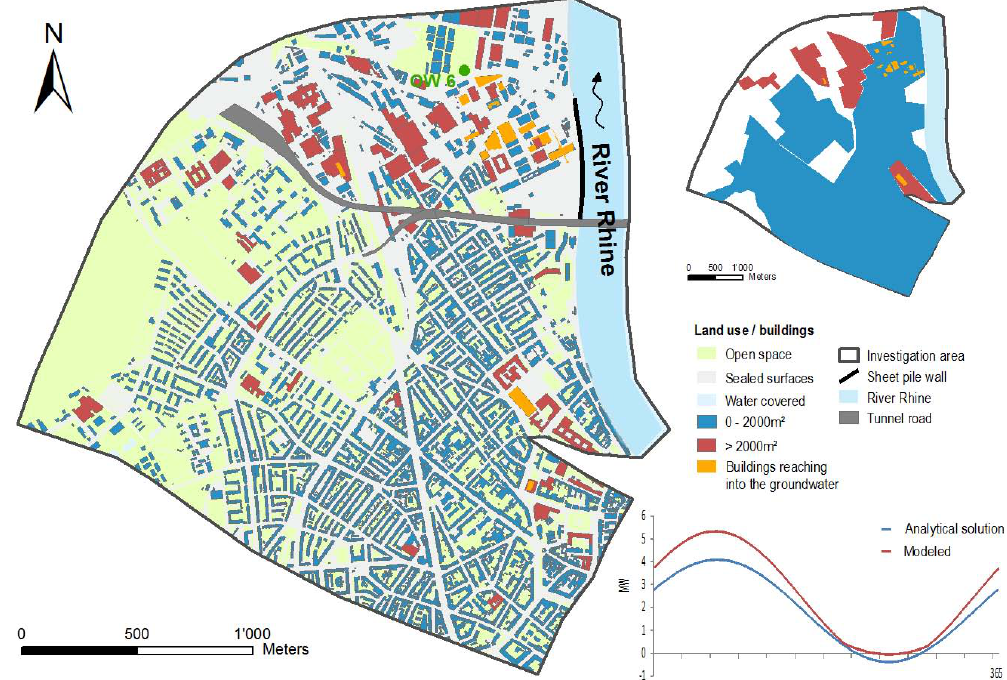
Fig. 2. Left panel: land use in the study area OW6: Temperature data used for heat flux calculation of large buildings reaching into the groundwater. Upper right panel: areas delineated for the consideration of heated buildings in the subsurface (small buildings with basement areas between 0 and 2000m 2 were considered within model layer 1; larger buildings with basement areas greater than 2000m 2 were considered in model layers 1 and 2; for buildings reaching into the groundwater the exact depth could be considered). Lower right panel: heat flux of small and larger buildings derived by an analytical solution and calibrated with the heat transport